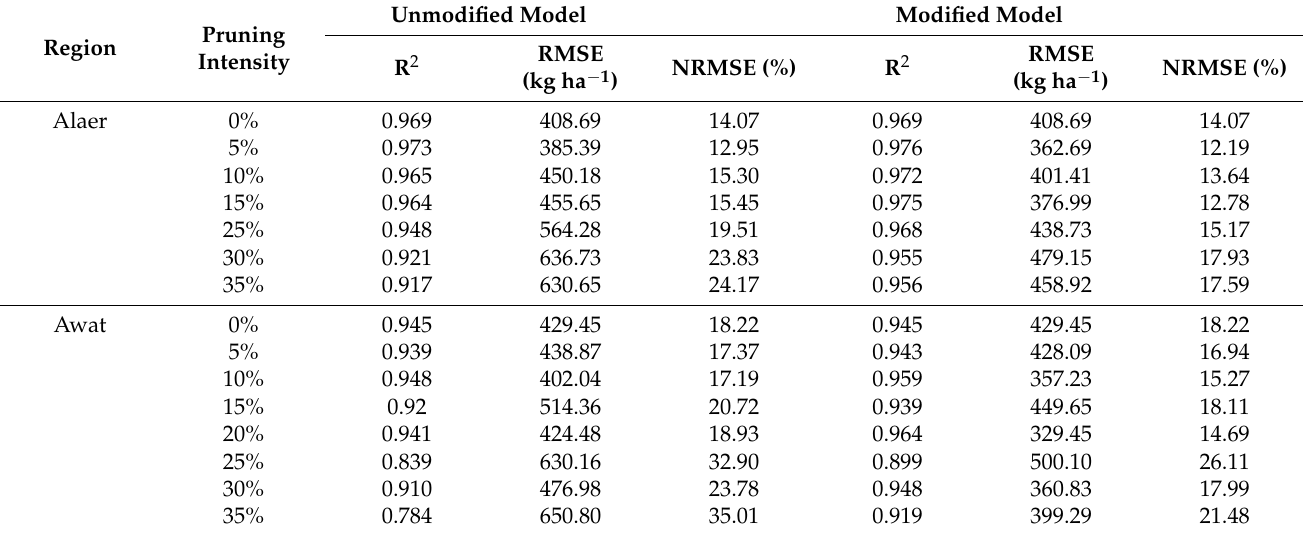
Table 2. Simulated TWSO validation for different